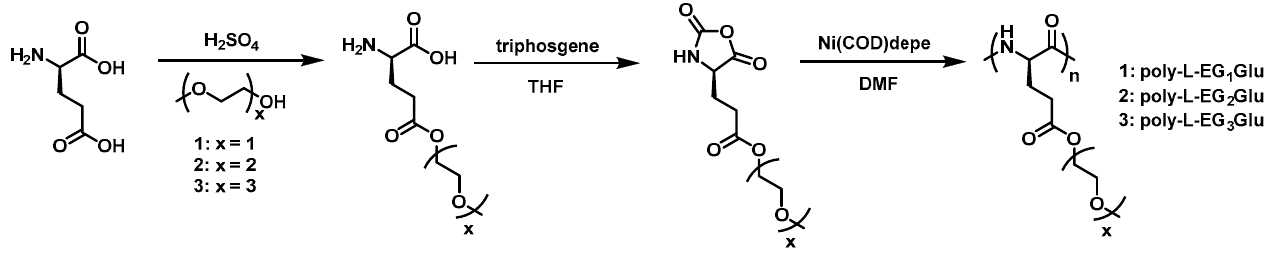
Figure 2. Synthetic route to poly- L -EGxGlu by Li et al. Reproduced with permission [34]. Copyright 2011, American Chemical Society.